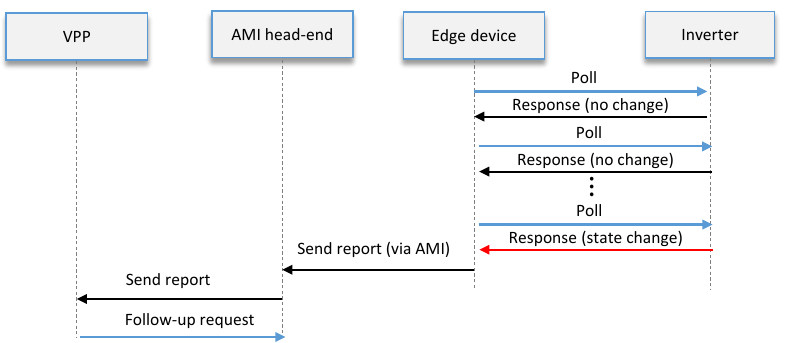
Figure 11. Illustrative case for an edge